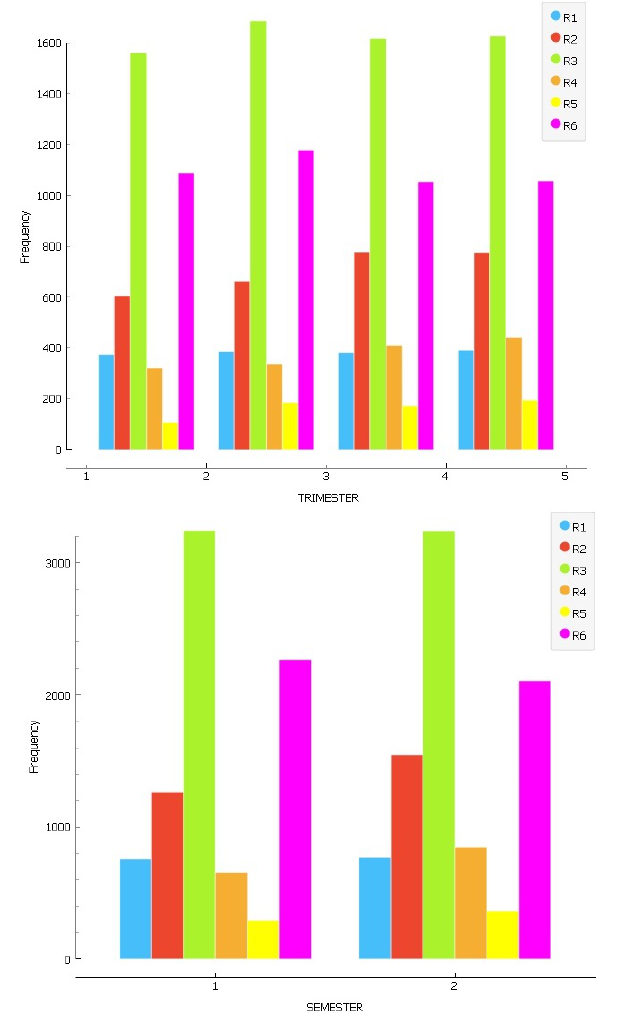
Figure 2. Data distribution by crime type in the periods: monthly, quarterly, and